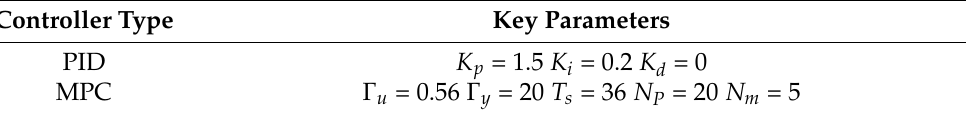
Table 4. Control parameters. Controller Type Key